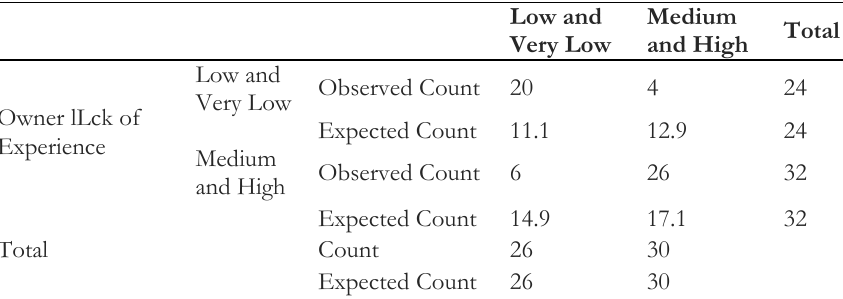
Table 6. Performance * design cross